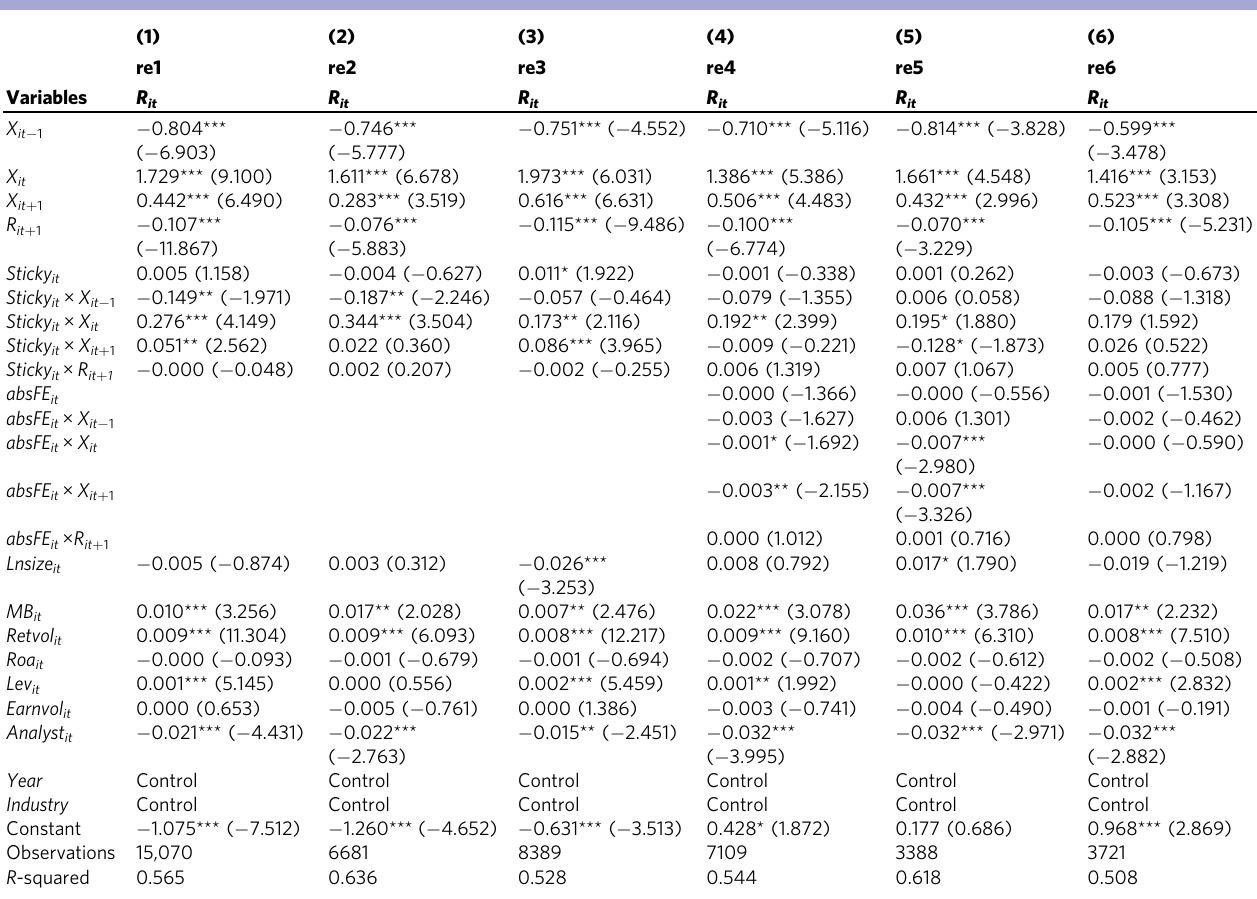
Table 7 The intermediary mechanism test of earnings response coef fi